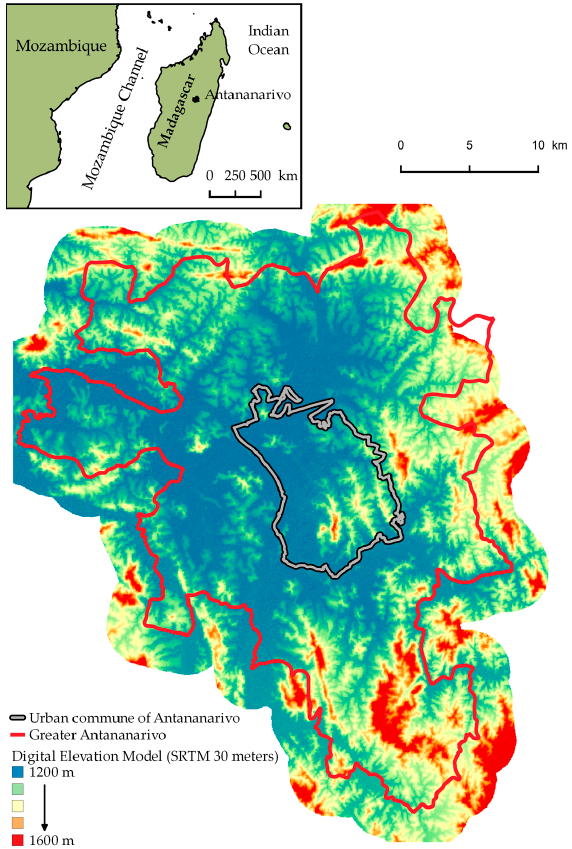
Figure 1. Location of the study area. SRTM, shuttle radar topography mission.